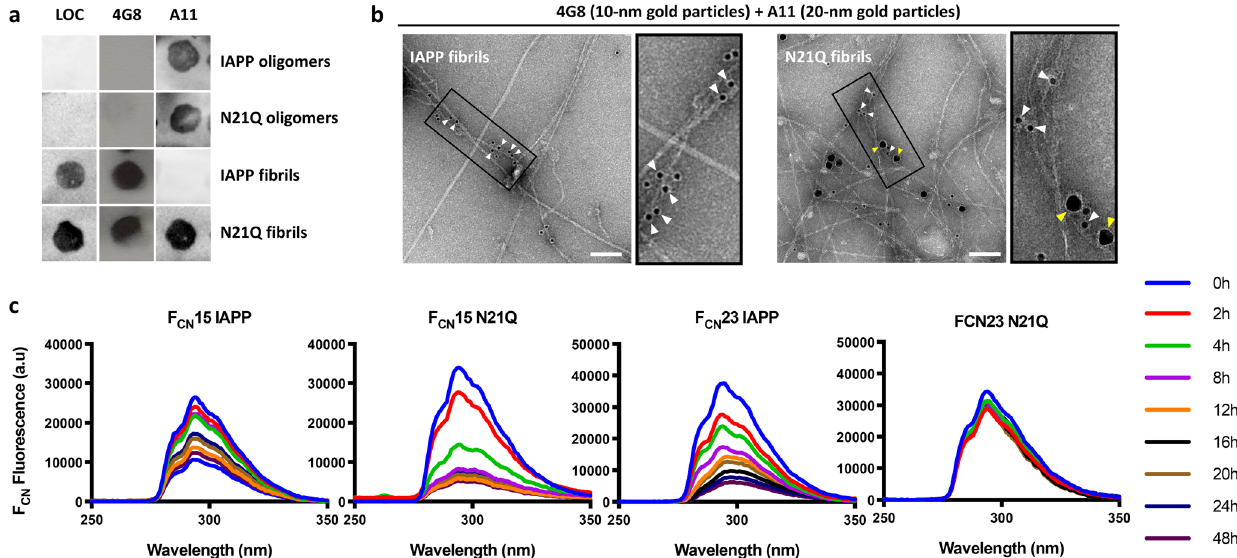
Fig. 5 N21Q fi brils exhibit oligomer-like conformation and expose residue F23. a Dot-blot analysis of IAPP and N21Q oligomers and fi brils. b Immunogold labelling electron microscopy images of IAPP and N21Q fi brils, scale bar: 100 nm. 3× zoom image of the region indicated by the rectangle. a , b Peptides were incubated under quiescent conditions for 15 min (oligomers) and 48 h ( fi brils) at 150 µ M in 20 mM Tris-HCl buffer, pH 7.4. c F CN fl uorescence emission spectra over self-assembly time. Peptides were incubated under quiescent conditions for 48 h at 150 µ M in 20 mM Tris-HCl buffer, pH